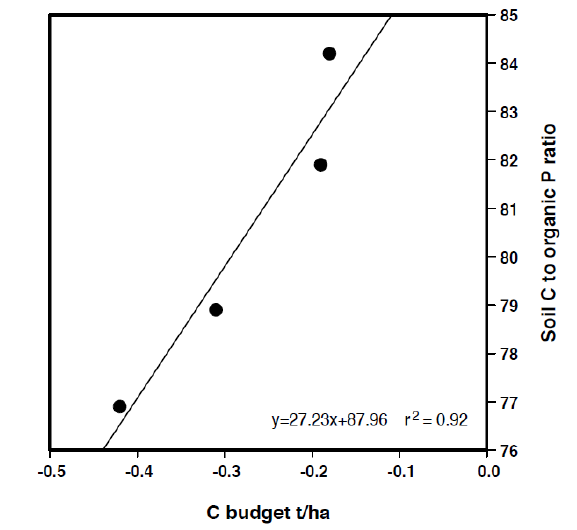
Figure 3. Relation between the C budget and the soil C:organic P molar ratio in the DOK field